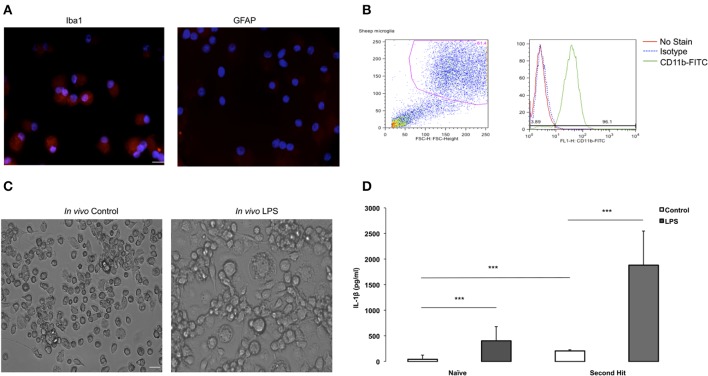
Purity validation of fetal sheep brain primary microglia in cultures and LPS second hit. (A) Photomicrographs (ICC) confirming cell purity. Iba1+ staining in microglia vs. undetectable GFAP signal in microglia indicating no contamination with astrocytes in the culture. Microglia were cultured in eight-well chamber slide with DMEM +5% FCS for 4–7 days. Microglia were collected from the floating fraction and stained for Iba1 and GFAP. Scale bar = 50 μm. Magnification 40× for both images. (B) Purity of fetal sheep brain primary microglia cultures was verified by flowcytometry. After several days in culture, fetal sheep microglia were scraped from the wells using a cell scraper and blocked for 30 min using normal mouse IgG and 10% human serum. Cells were then stained using a FITC-conjugated monoclonal bovine anti-CD11b (1:40, Bio-Rad) on ice for 20 min. Cells were washed in FACS buffer and analyzed using a BD FACSCalibur and FlowJo software. (C) Microglia from in vivo LPS exposed brain appear more aggregated in vitro than microglia derived from in vivo controls. Microglia were cultured in 24-well plates with DMEM +5% FCS for 4–7 days, when images were taken. Cells were extracted from a twin control fetal brain and an in vivo LPS exposed fetal brain (Magnification 20× for both images). (D) Effect of “second-hit” in vitro LPS treatment on microglial phenotype. BOTTOM: IL-1β concentration in conditioned media of microglia derived from fetal sheep brain that were exposed to LPS vs. saline in vivo (***P < 0.0001). Cultures from in vivo LPS-exposed (SH), n = 4, cultures from in vivo Control (Naïve), n = 10. Cell culture media supernatant was obtained by centrifugation upon cell culture termination. A sheep specific IL-1β ELISA was performed to measure cytokine levels in cell culture media. In vitro, at baseline, microglia secreted more IL-1β in the in vivo LPS group (SHC) than in naïve Control (NC). LPS re-exposure (SHL) further increased IL-1β vs. naïve LPS (NL) by ~4.6-fold.